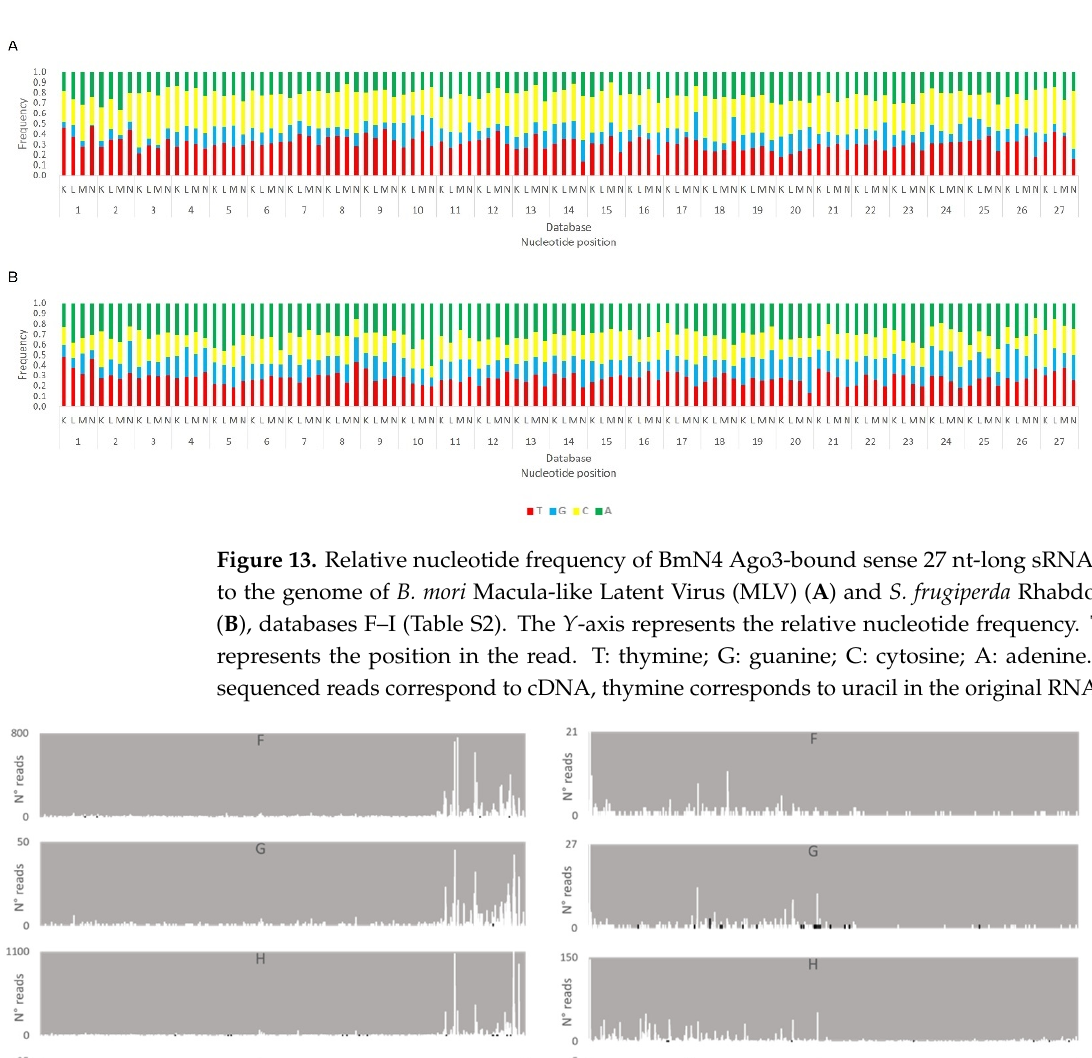
Figure 12. Relative nucleotide frequency of BmN4 Siwi-bound sense 28 nt-long sRNAs, mapped to the genome of B. mori Macula-like Latent Virus (MLV) ( A ) and S. frugiperda Rhabdovirus (RV) ( B ), databases F–I (Table S2). The Y -axis represents the relative nucleotide frequency. The X -axis represents the position in the read. T: thymine; G: guanine; C: cytosine; A: adenine. Since the sequenced reads correspond to cDNA, thymine corresponds to uracil in the original RNA molecule.